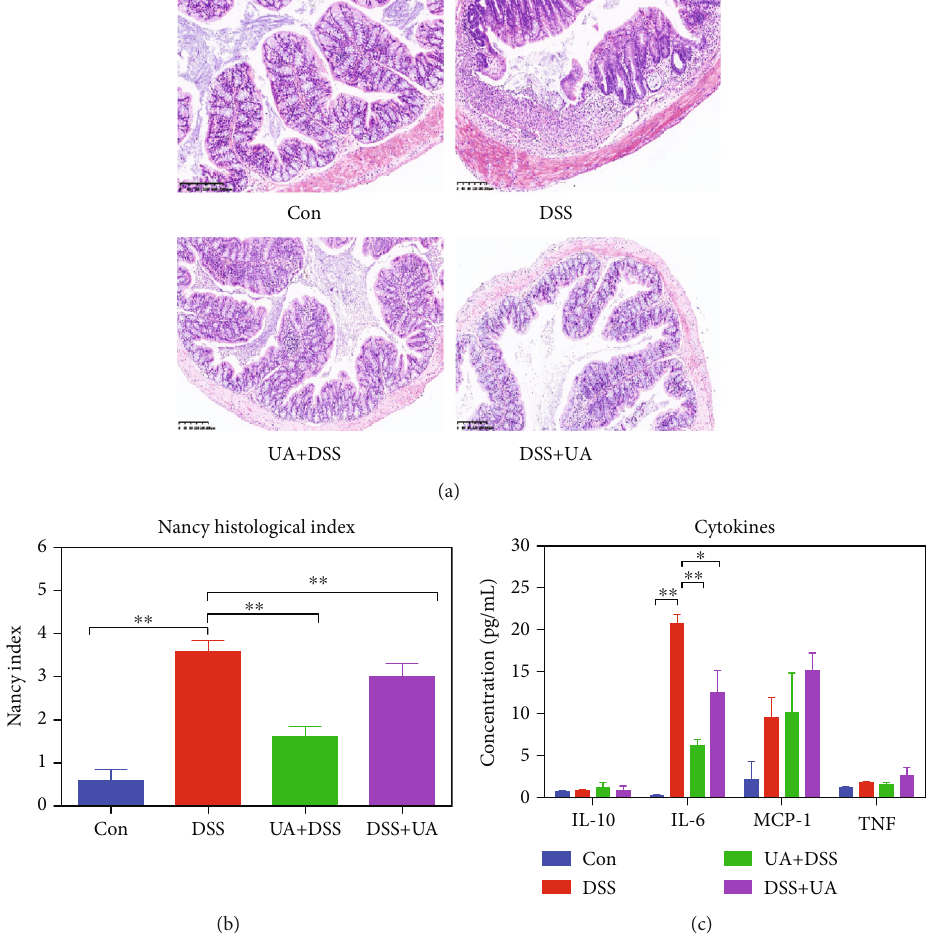
Figure 2: E ff ects of the UA against colon in fl ammatory and injure. (a) The histopathology of the colon by HE stain in the DSS-induced UC model and UA treatment groups. (b) Nancy index of each group according to the Marchal-Bressenot method in each group ( n = 8 ). (c) E ff ects of UA on serum levels of four cytokines in the DSS-induced UC model and UA treatment groups ( n = 8 ). Data represent the mean ± SEM of values per group. Statistically signi fi cant results in di ff erent groups are marked by ∗ P < 0 : 05 and ∗∗ P < 0 : 01 . There was no signi fi cant di ff erence in the unmarked